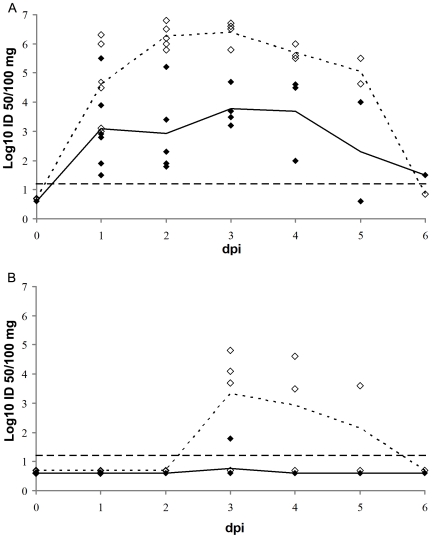
Kinetics of nasal excretion of Ck/B/99 and Sw/B/98 viruses in pigs.Individual virus titers after intranasal (A) or intratracheal (B) inoculation with Ck/B/99 (filled squares) and Sw/B/98 (open squares) viruses are given from 1 up to 6 dpi. Mean virus titers of Ck/B/99 and Sw/B/98 are displayed as full and dashed lines respectively. ---: detection limit. Virus titres were significantly higher for Sw/B/98 than for Ck/B/99 (P<0.05) and after intranasal than after intratracheal inoculation with both viruses (P<0.05).